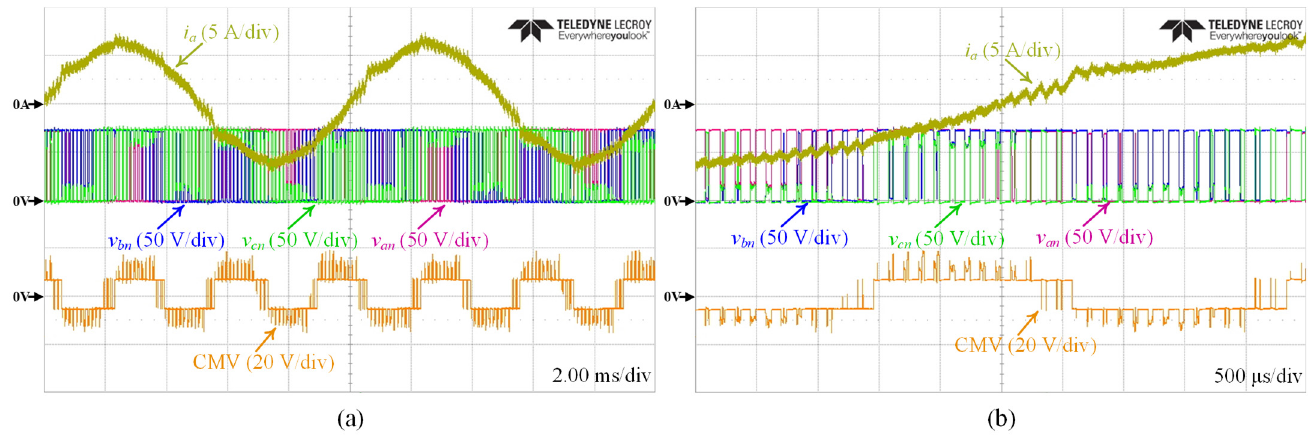
Figure 21. Experimental results of a -phase current, three-phase pole voltage, and CMV at rated load current and rotor speed of 1200 rpm: ( a ) i a , v a , v b , v c , and CMV; ( b ) Magnified waveforms of ( a ).